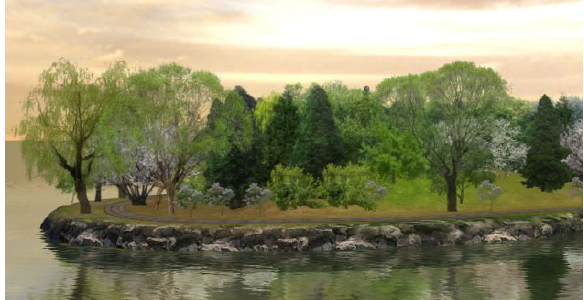
Figure 10. Plants scene before the adjustment